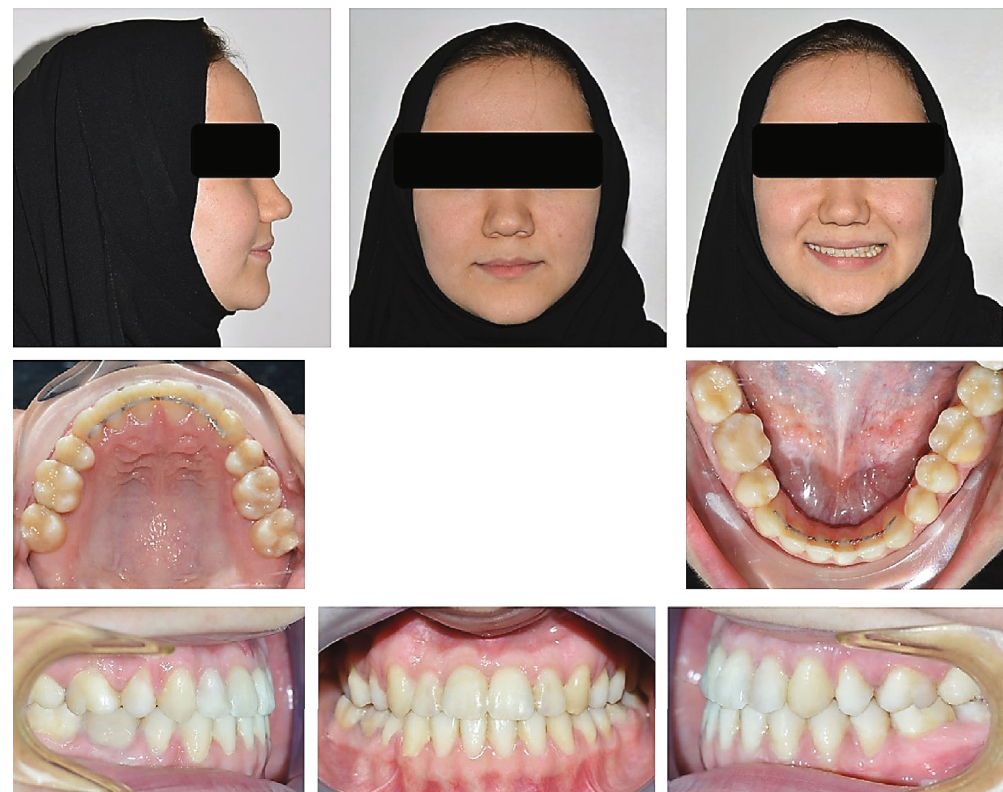
Figure 5: Posttreatment photographs of the patient.